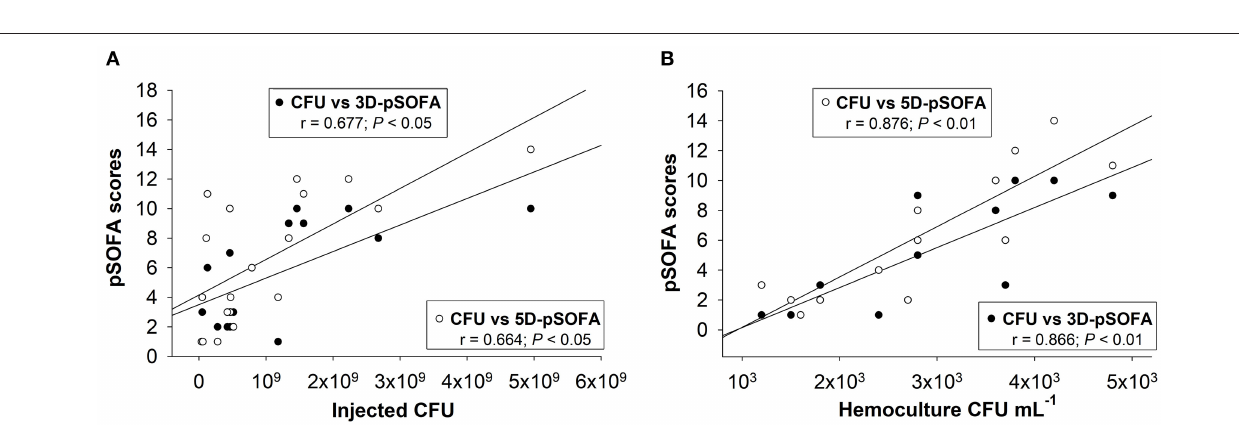
monitoring in the septic shock subgroup ( Figure 8A ). In